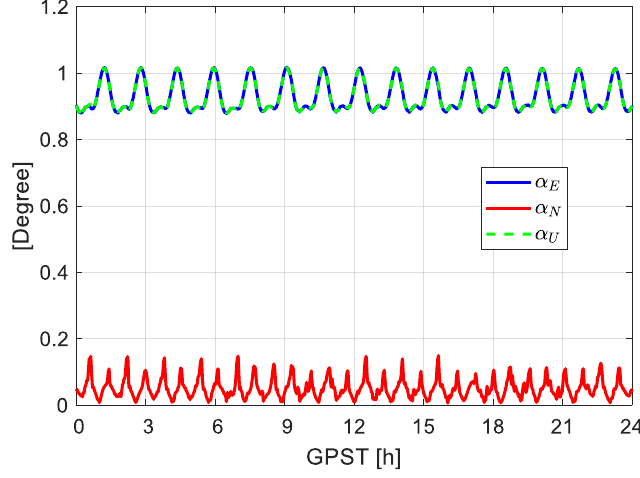
Figure 11. Angle differences between the east, north, and up directions in the antenna reference frame (ARF) and the opposite along-track direction, the cross-track direction, and the radial direction. The data for GRACE FO-1 was used for the plot. Note that the blue line is almost overwritten by the green dashed line.